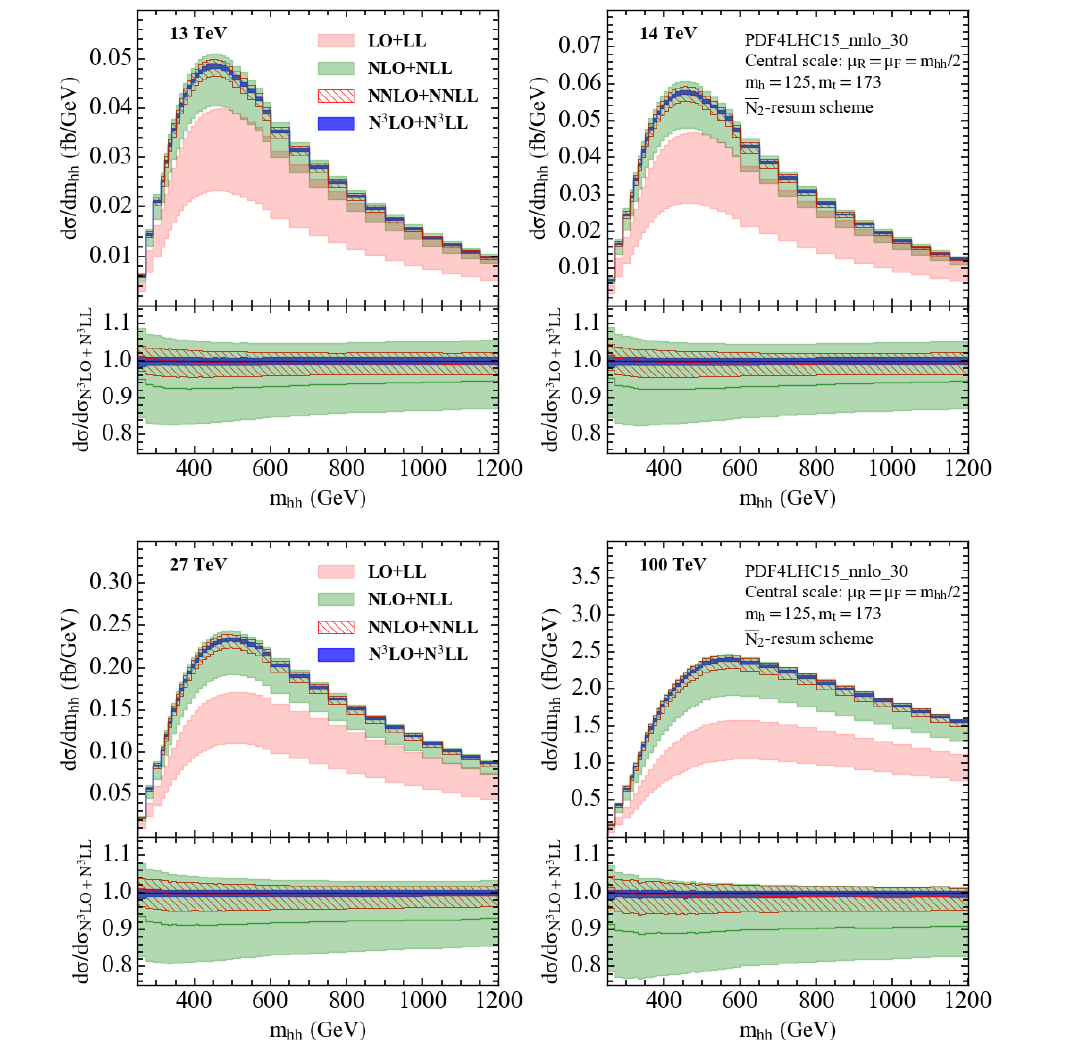
from LO+LL to N 3 LO+N 3 LL at four Figure 4 . The invariant mass differential cross sections dσ dm hh √ different center-of-mass energies s = 13 , 14 , 27 , 100 TeV. The error bands represent the 7-point scale variations with the central scale µ = m hh . The pink, green, red hatched and blue bands 0 2 correspond to the LL+LO, NLO+NLL, NNLO+NNLL and N 3 LO+N 3 LL predictions, respectively. The bottom panel shows the ratios to the N 3 LO+N 3 LL